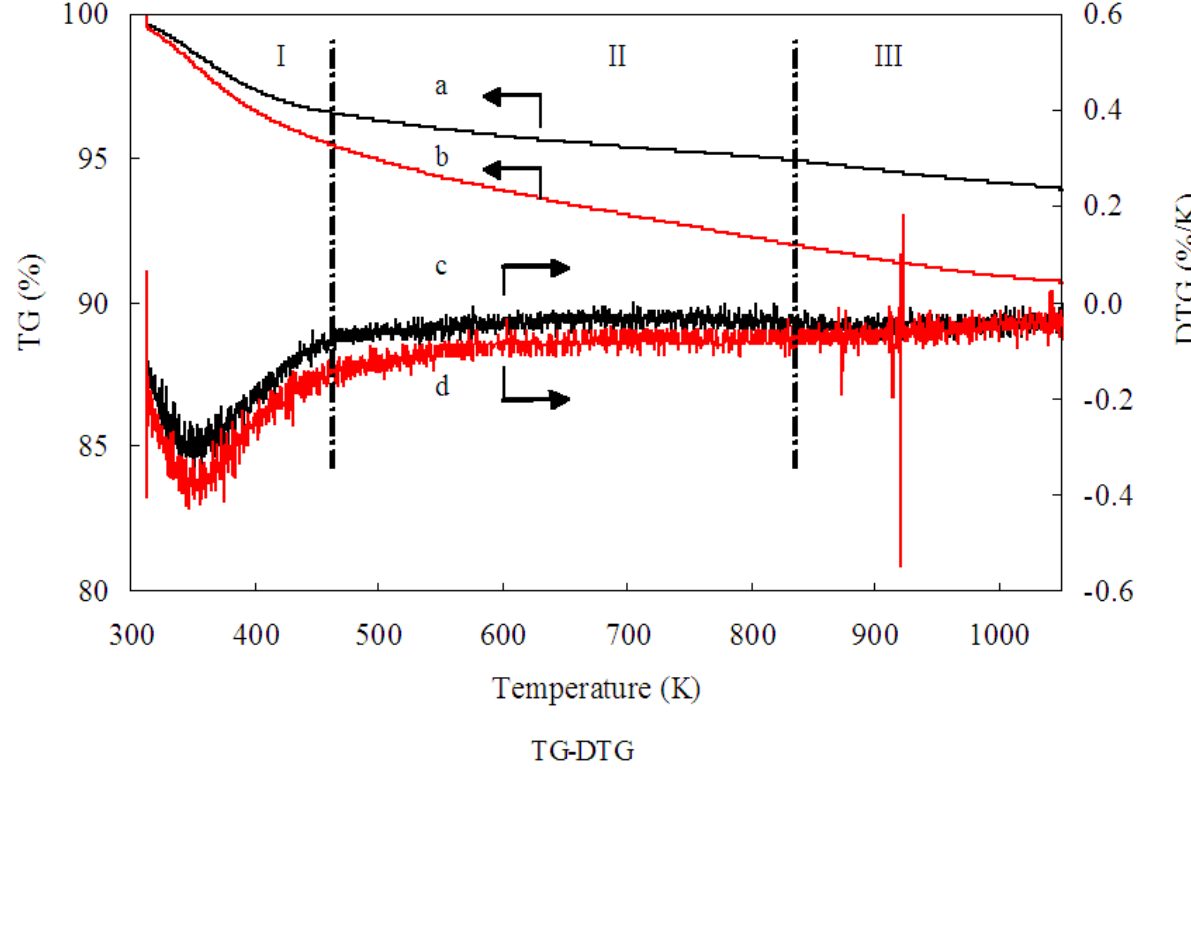
Figure 2. Thermogravimetric (TG) analysis profiles of (a) Al 2 O 3 ; (b) Au/Al 2 O 3 and differential thermogravimetric (DTG) analysis profiles of (c) Al 2 O 3 ; (d) Au/Al 2 O 3 . Black arrow a: TG analysis profiles of Al 2 O 3 ; Black arrow b: TG analysis profiles of Au/Al 2 O 3 ; Black arrow c: DTG analysis profiles of Al 2 O 3 ; Black arrow d: DTG analysis profiles of Au/Al 2 O 3